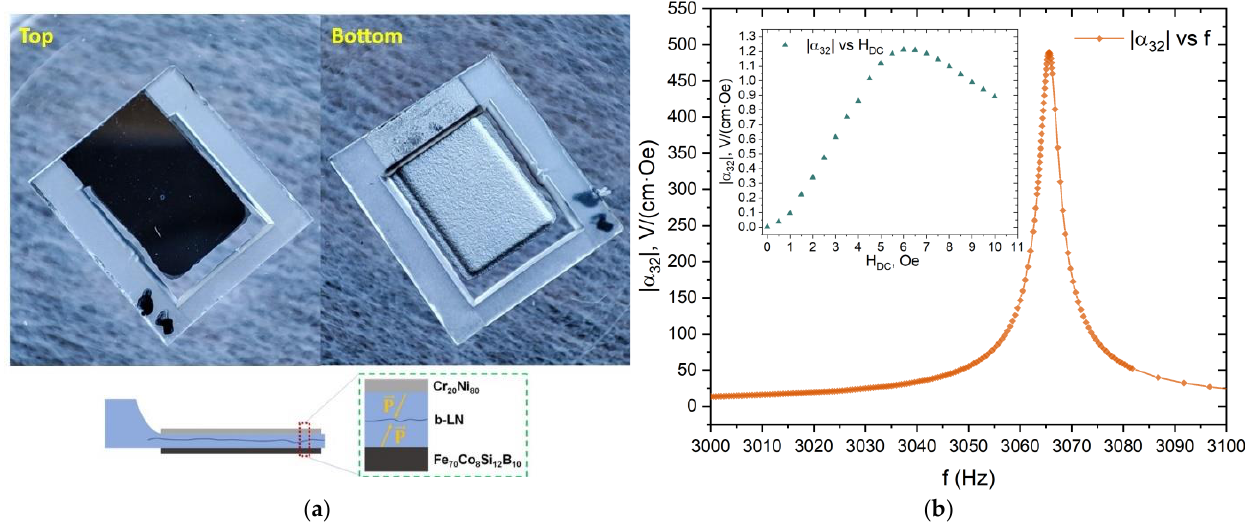
Figure 8. ( a ) Photo of the top and bottom view of the ME MEMS sample and schematic layer structure, where the arrows indicate spontaneous polarization vectors in the head-to-head bidomain LN crystal. ( b ) Dynamic direct ME coefficient | α 32 | measured as a function of the frequency of AC magnetic field with an amplitude of 0.1 Oe and the optimal bias field H = 6 Oe. The inset shows the quasi-static in- plane direct ME coefficient |α 32 | measured as a function of the DC magnetic field.